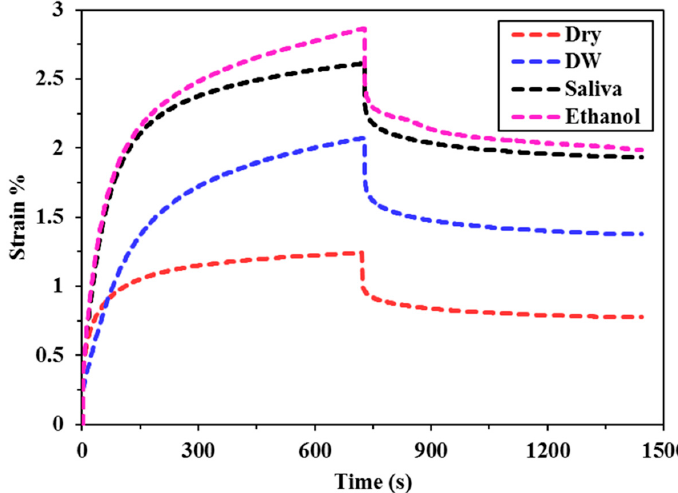
Figure 5. Creep deformation and recovery of TNCBF in various FSOS.